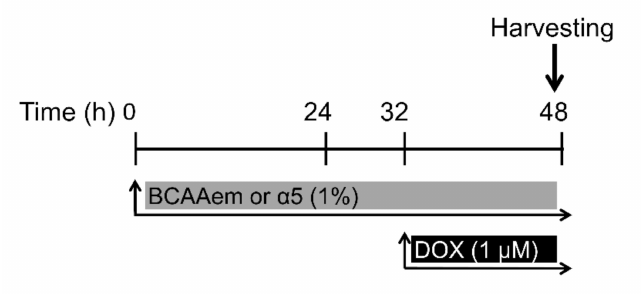
Figure 1. HL-1 cell treatment. Table 1. BCAAem and α 5 composition (relative